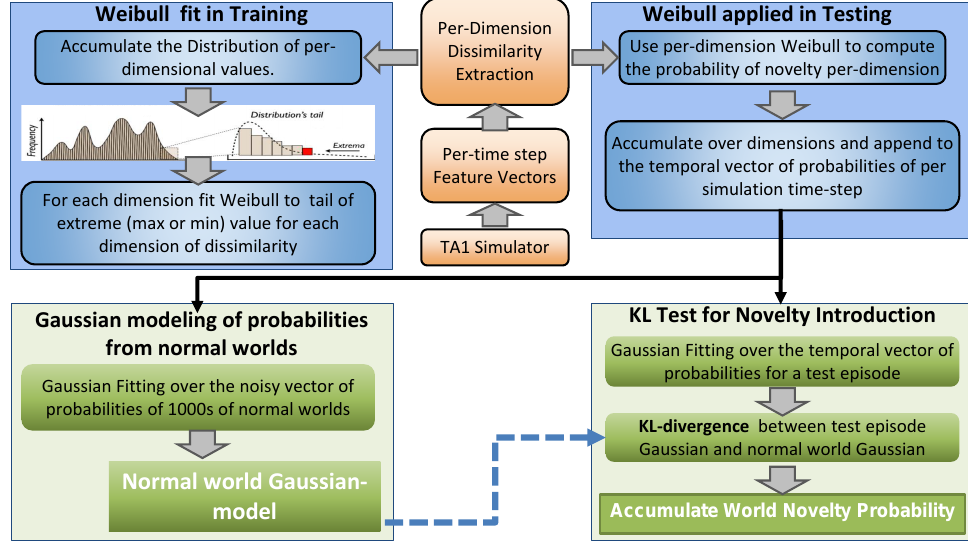
Figure 3. Overall novelty processing per instance and per episode. Data is collected from each dissimilarity dimension during testing, and Weibulls are fit the extreme value for each. Given a trial, at each time step, the dissimilarity values are computed and the per-dimensional Weibull models yield probabilities that accumulated over dimensions and appended to a temporal probability vector. For 300 normal trials, i.e., examples of normal worlds, the system builds a Gaussian model (mean/standard deviation) of the elements of the temporal probability vector. For each episode of a test trial, the temporal probability vector is computed and KL-divergence is computed comparing that to the Gaussian of the normal world. The per-episode probabilities are accumulated over time to allow for high sensitivity with low false detection